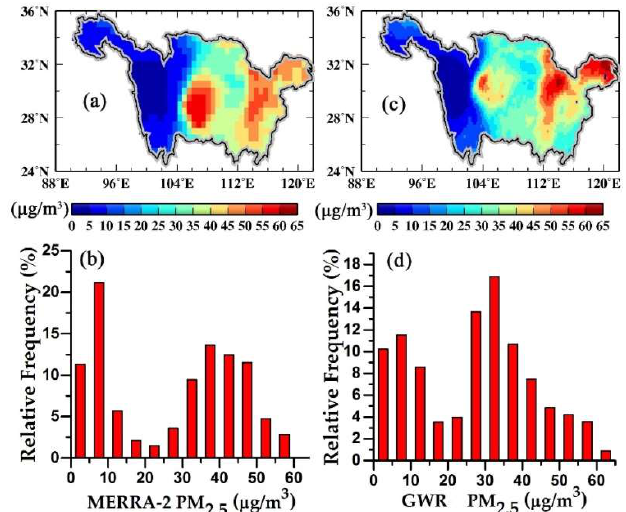
Figure A2. The spatial (top) and frequency (bottom) distributions of multiyear-averaged surface PM 2.5 concentrations derived from MERRA-2 (a-b), GWR-1 (c-d) over the YRB for the period of 1998 – 2016.